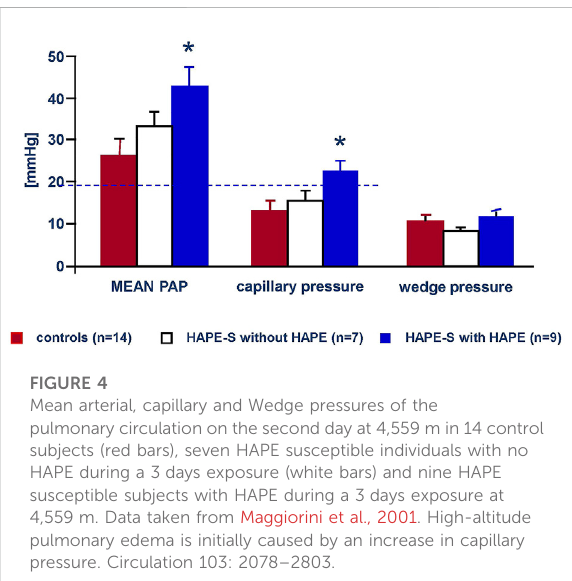
FIGURE 4 Mean arterial, capillary and Wedge pressures of the pulmonary circulation on the second day at 4,559 m in 14 control subjects (red bars), seven HAPE susceptible individuals with no HAPE during a 3 days exposure (white bars) and nine HAPE susceptible subjects with HAPE during a 3 days exposure at 4,559 m. Data taken from Maggiorini et al., 2001. High-altitude pulmonary edema is initially caused by an increase in capillary pressure. Circulation 103: 2078 –